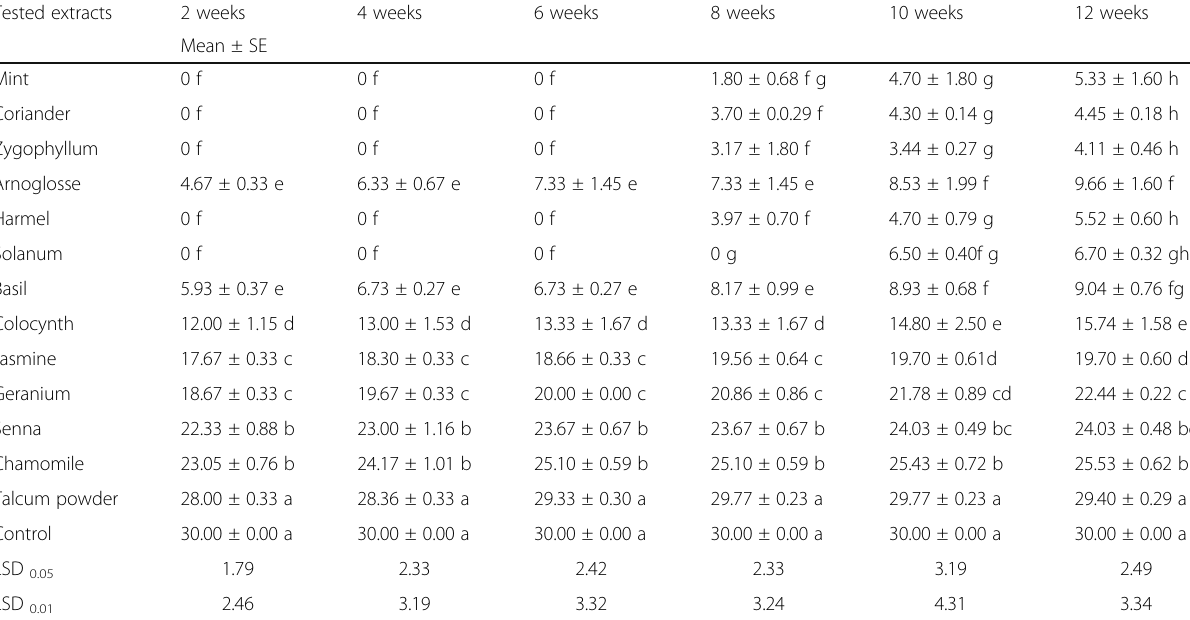
Table 2 Continuity of extracts in preventing the stored tubers from PTM infestation during different periods Tested extracts